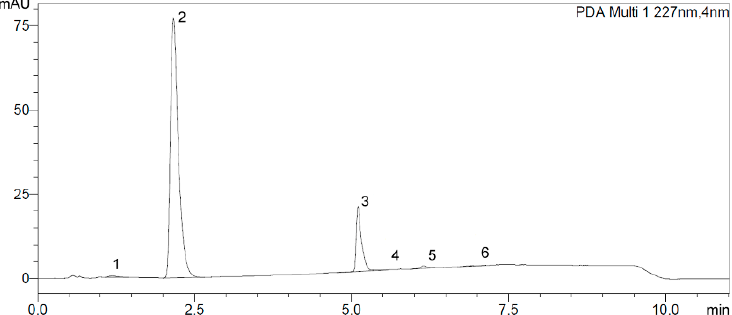
Figure 1. Chromatogram of the GLSs profile in wall rocket obtained with UHPLC by the external service.